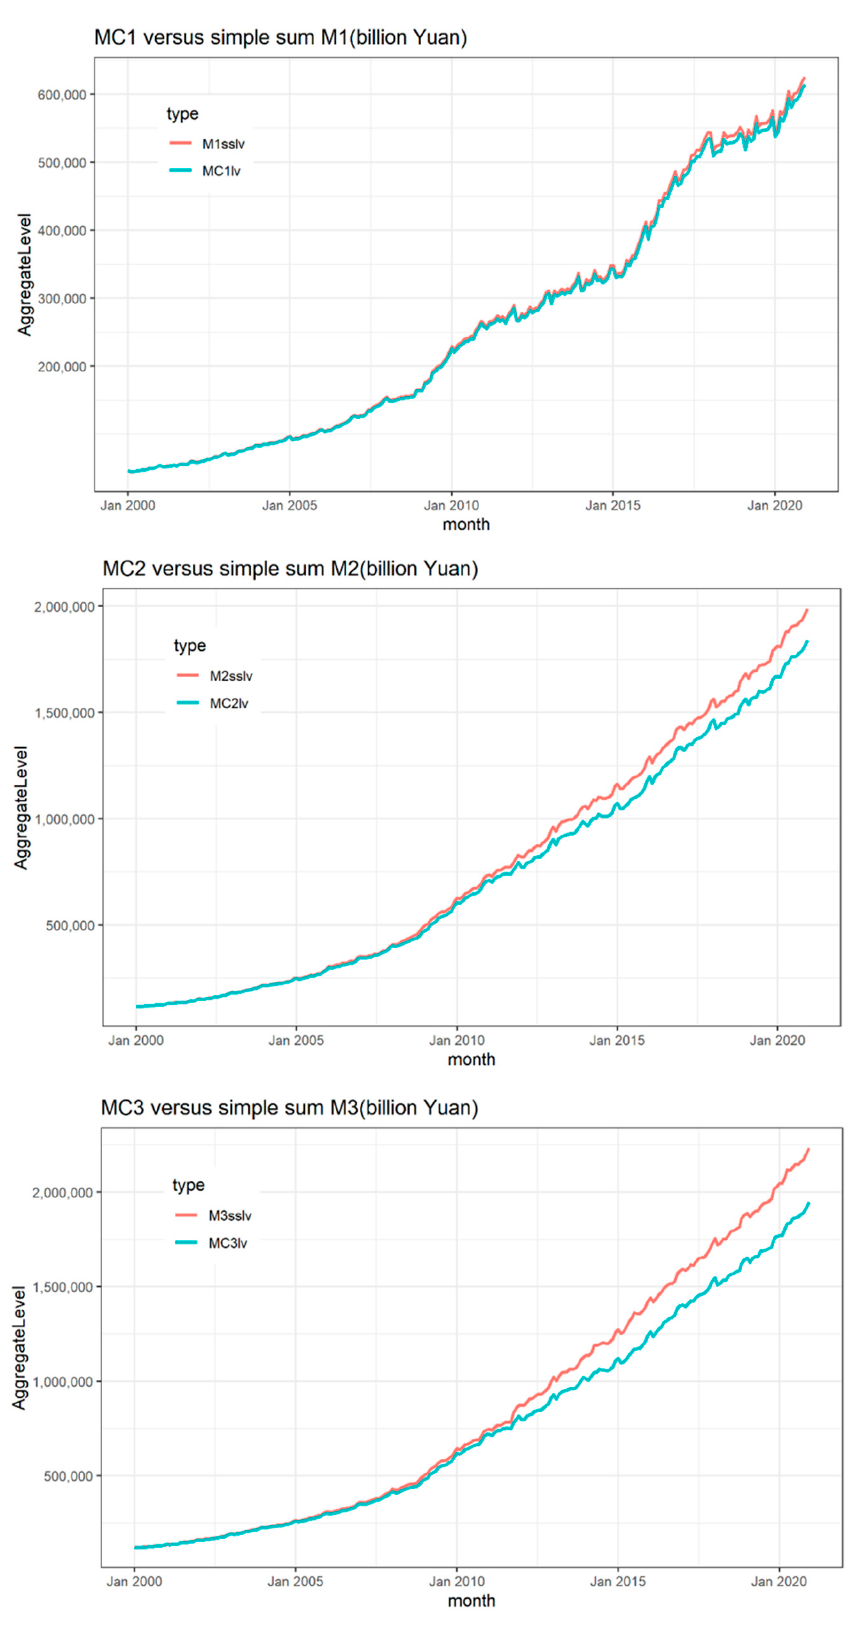
Figure 6. Divisia monetary aggregates and simple sum (billions of Yuan).